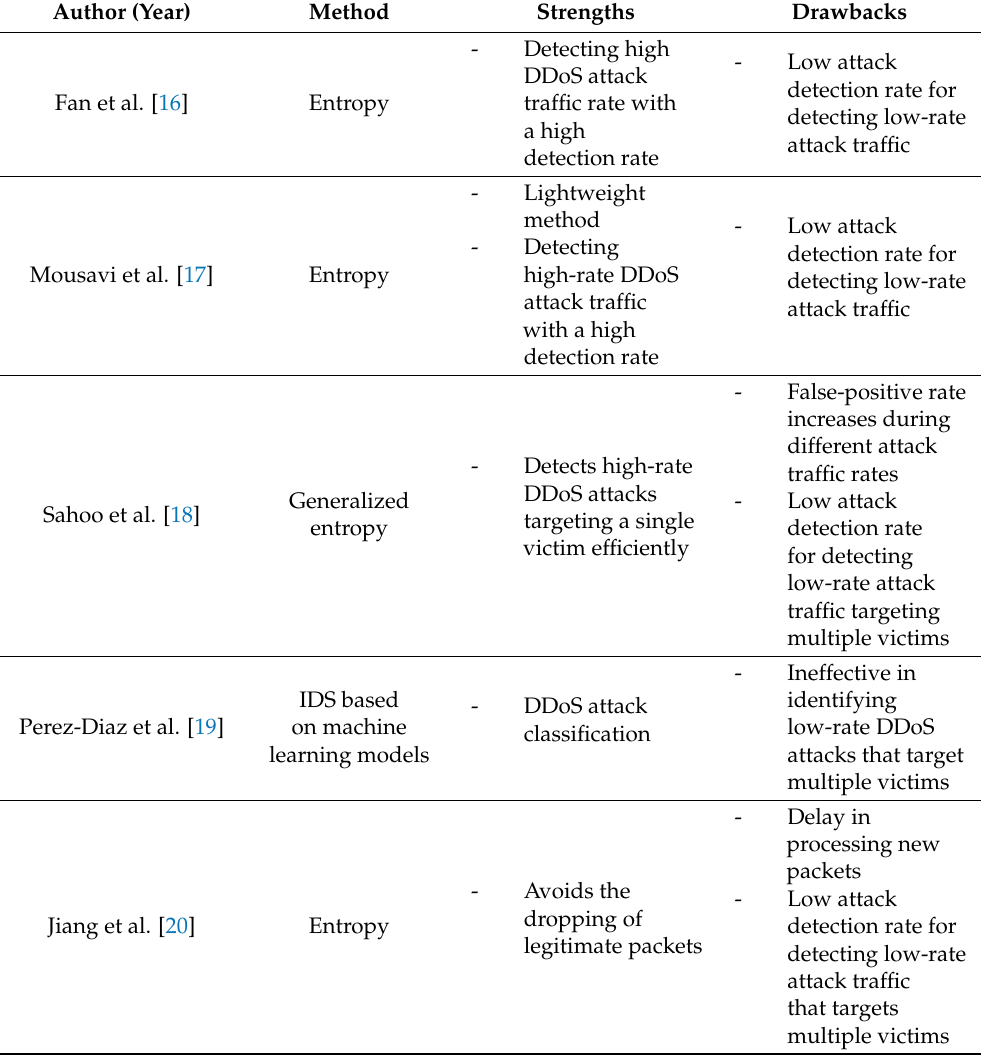
Table 1. Summary of work related to DDoS detection approaches against